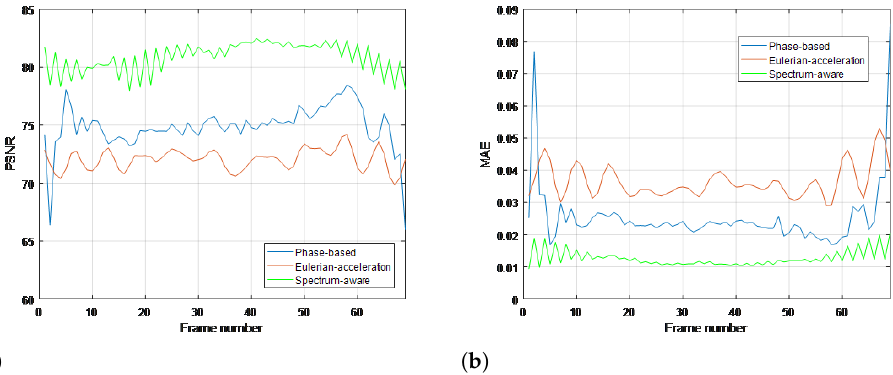
Figure 9. Objective metrics with ground truth for each magnification processing using ( a ) PSNR and